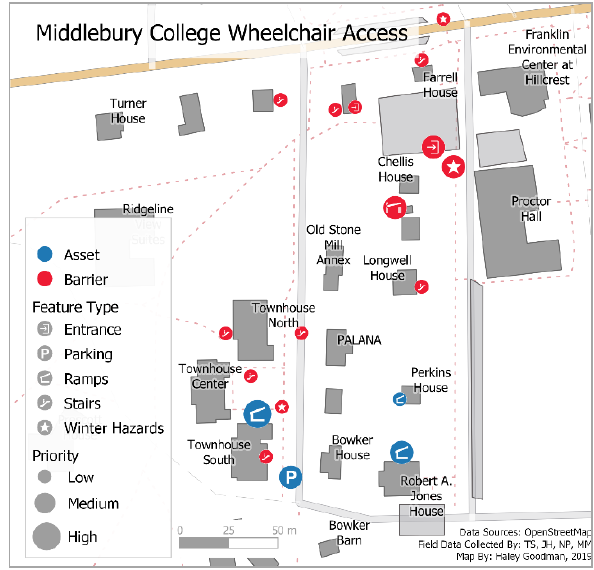
Figure 1. Campus mobility map by student Haley